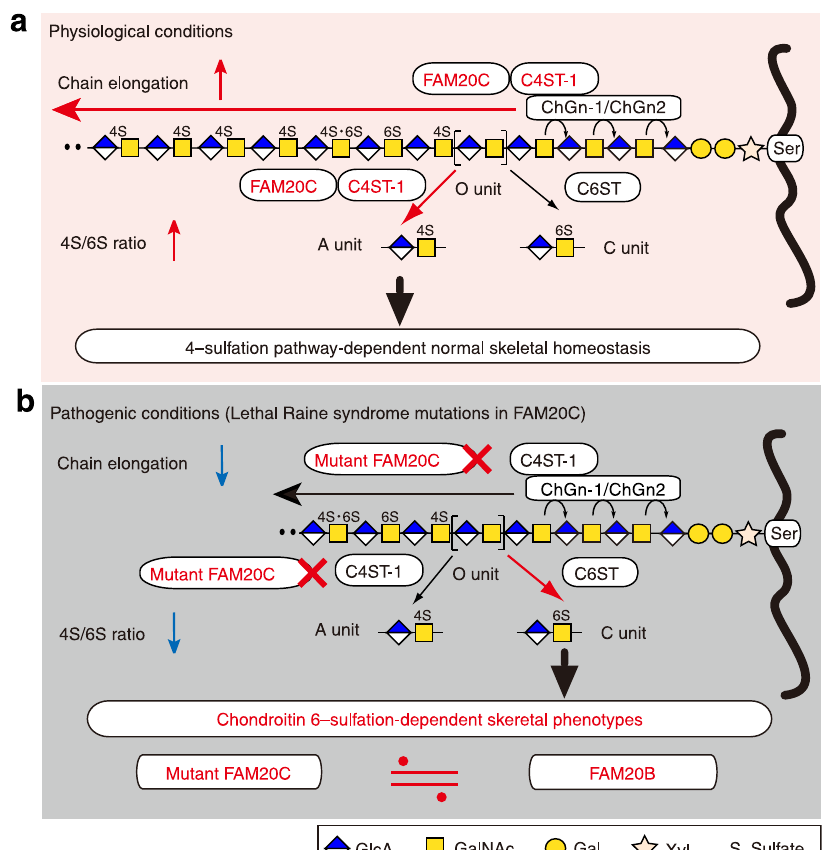
Fig. 6 | Non-enzymatic functions of FAM20C in the control of CS biosynthesis and its involvement in Raine syndrome etiology. In physiological states ( a ), FAM20CcanphysicallyinteractwithC4ST-1andaugmenttheenzymaticactivityof C4ST-1, leading to increased length of the individual CS chains via cooperative actions with glycosyltransferases ( N -acetylgalactosaminyltransferases; ChGns) 20,33 and to an elevated 4S/6S ratio. In contrast b , lethal Raine syndrome mutations in